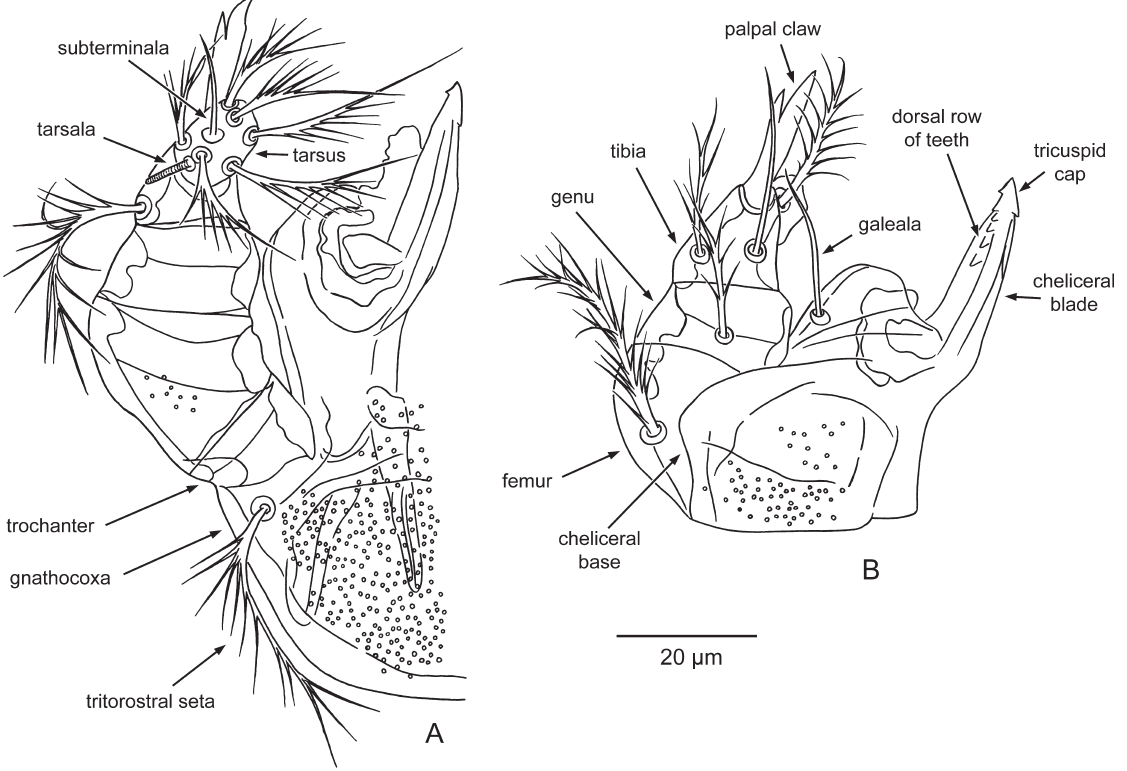
Fig. 3. Palps of an example of Schoengastia sp. A . Ventral aspect. B . Dorsal